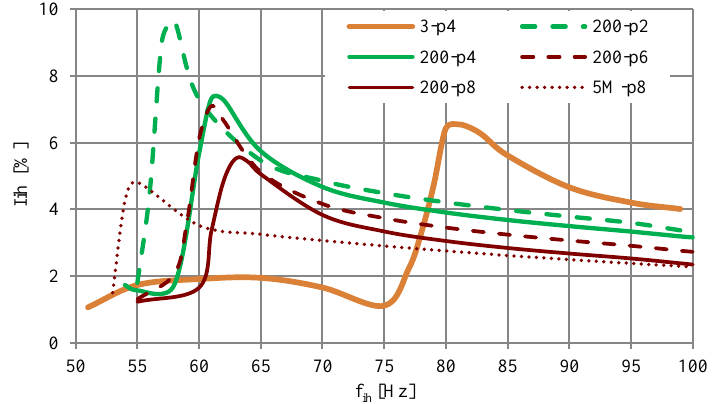
Figure 7. Computed current interharmonics vs. the frequency of voltage interharmonics for the various motors and the case of negligible moment of inertia (NMI).